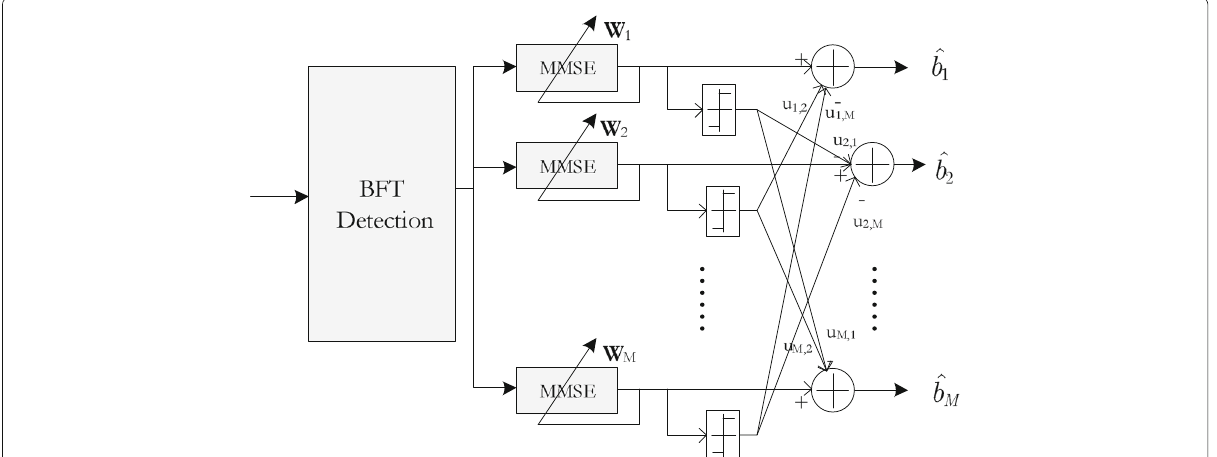
Fig. 4 Block diagram of MMSE-PIC algorithm for detecting the multichirp-rate signal in the multipath environment. The figure shows the structure of MMSE-based algorithm to suppress the